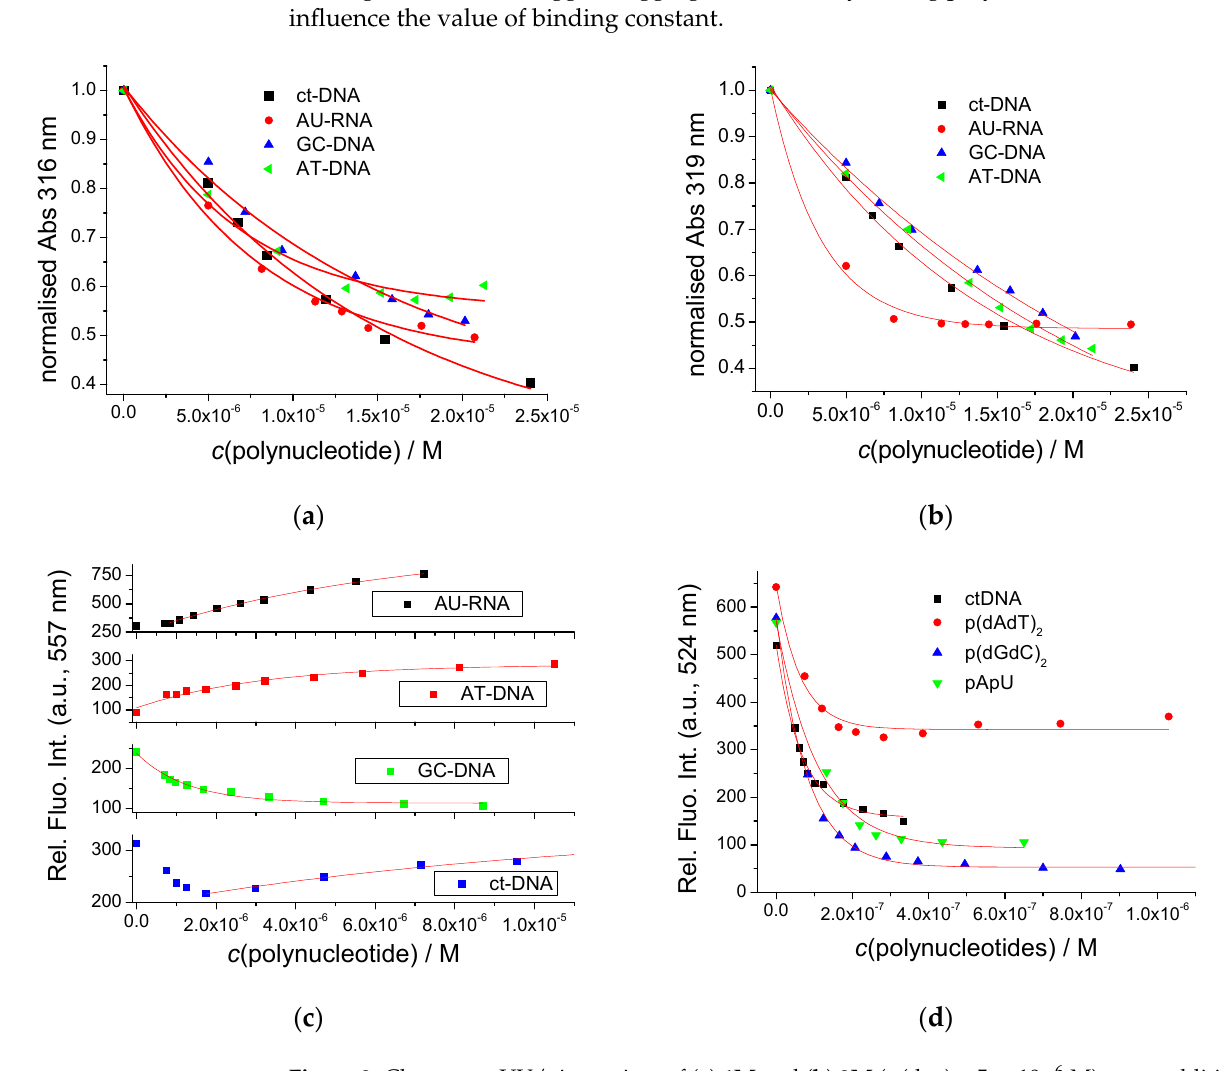
Figure 2. Changes at UV/vis maxima of ( a ) 1M and ( b ) 2M ( c (dye) = 5 × 10 − 6 M) upon addition of polynucleotides; the Y-axis was normalised to starting absorbance value of a free dye. Changes at fluorescence maxima of ( c ) 1M and ( d ) 2M ( c (dye) = 5 × 10 − 8 M) upon addition of polynucleotides. All titrations were conducted at pH 7.0, sodium cacodylate buffer , I = 50 mM. At concentrations necessary for accurate UV/vis titrations ( c = 5 × 10 − 6 M), non- methylated 1 or 2 precipitated upon DNA/RNA addition.